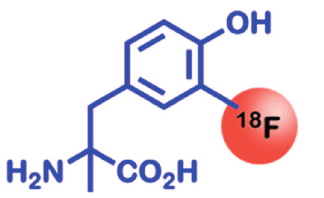
Figure 3. Chemical structure of L -[3- 18 F]- α -methyl-tyrosine, a PET tracer specifically taken up via amino acid transporters, which are overexpressed in many types of